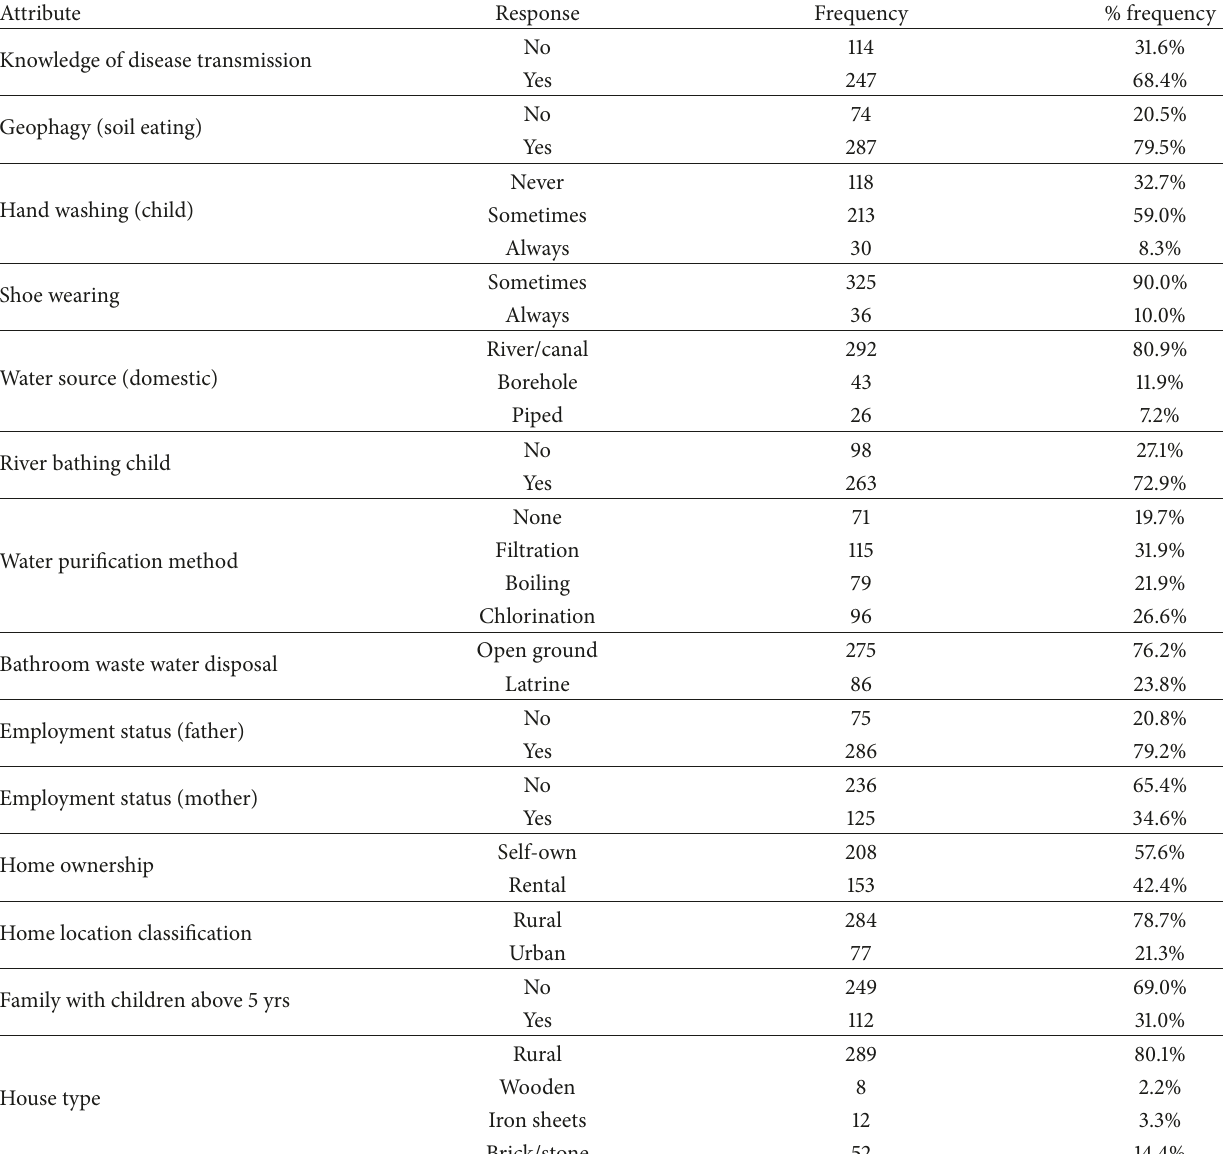
Table 3: Frequency distribution of socioeconomic characteristics of the sampled study